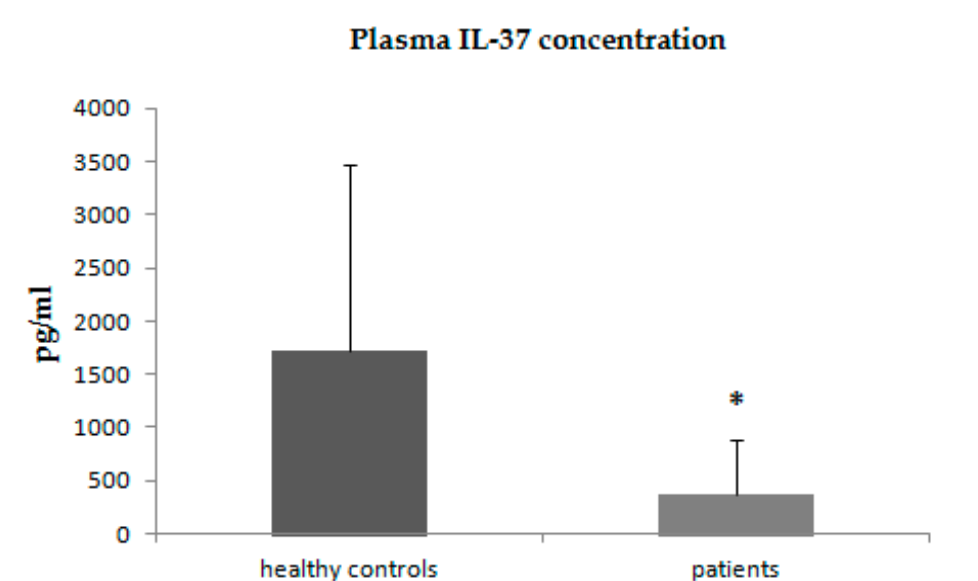
Figure 2. Plasma concentrations of IL ‐ 36 β in patients with psoriasis and control group. * p < 0.001. The concentrations of IL ‐ 37 were statistically significantly lower in patients with psoriasis in comparison with control subjects (Figure 3).